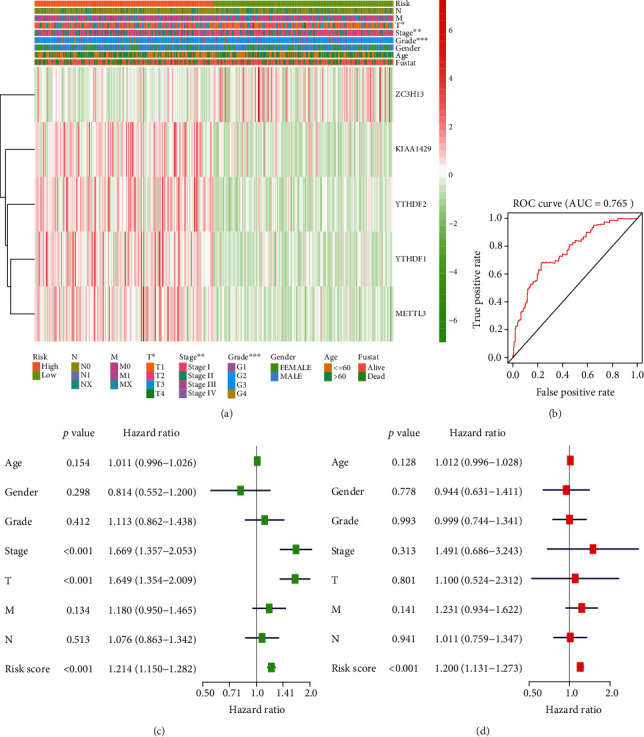
Effects of the risk score and clinicopathological variables on the prognosis of hepatocellular carcinoma patients. (a) The heatmap shows the expression of five m6A RNA methylation regulators and the distribution of clinicopathological variables between the high- and low-risk groups (red is upregulated and green is downregulated; ∗p < 0.05, ∗∗p < 0.01, and ∗∗∗p < 0.001). (b) ROC curves showed the predictive efficiency of the risk signature. (c) Cox univariate analyses of clinicopathological variables (including the risk score) and overall survival. (d) Cox multivariate analyses of clinicopathological variables (including the risk score) and overall survival.